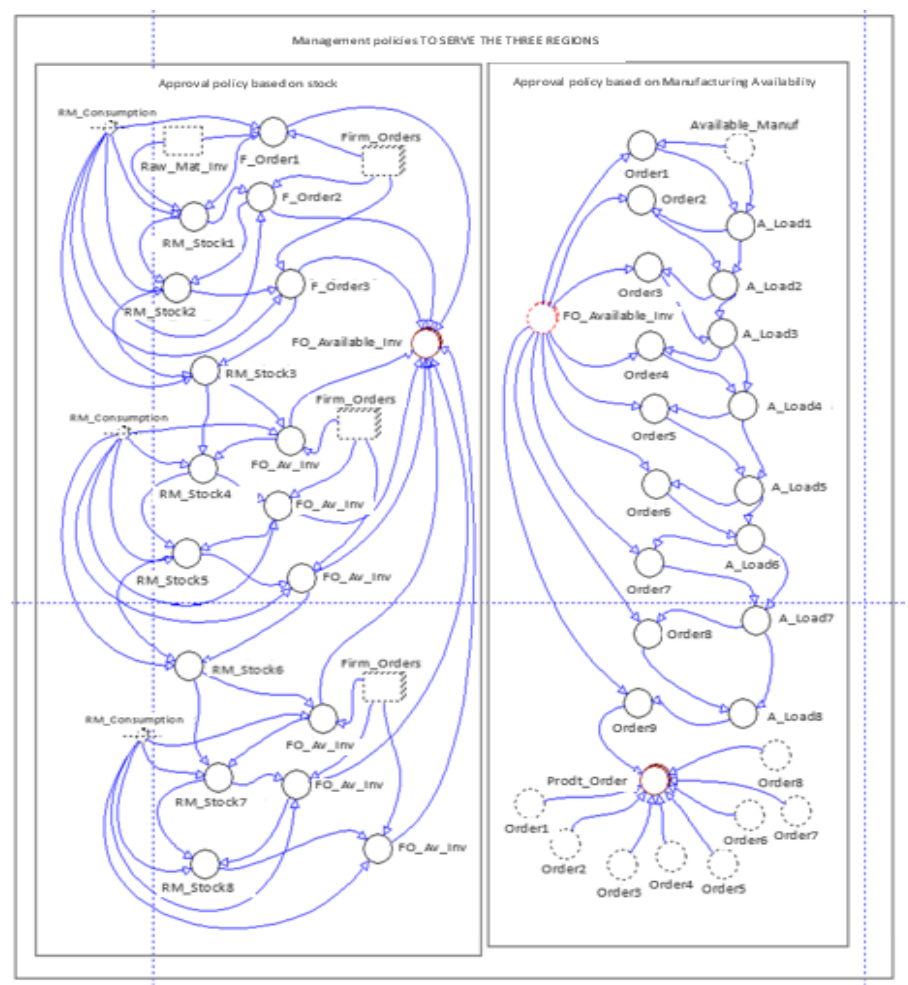
Figure 13. Management policies to serve the regions — scenario 2. Source: own elaboration. Evolu- Figure 11. Management policies to serve the regions—scenario 2. Source: own elaboration. tion software. Evolution software. Table 7. Scenario 2